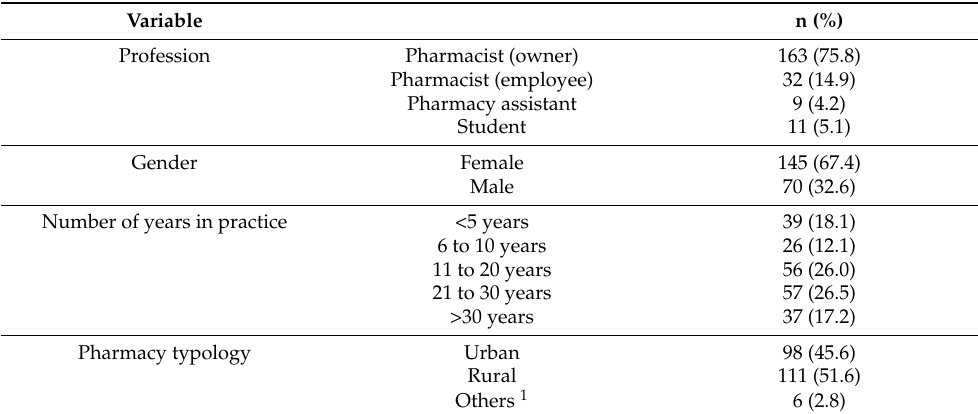
Table 1. Sociodemographic characteristics of the pharmacists in our